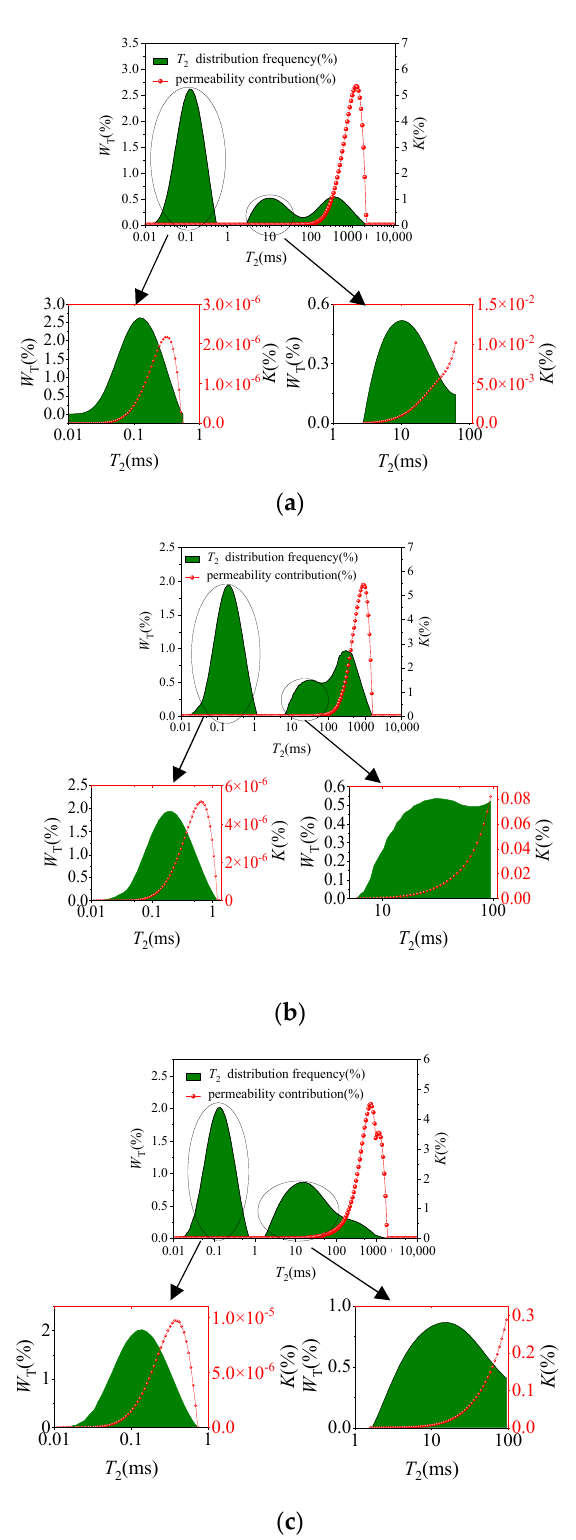
Figure 8. Permeability contribution curves of coal samples based on NMR. ( a ) N1, ( b ) N2, and ( c ) N3.